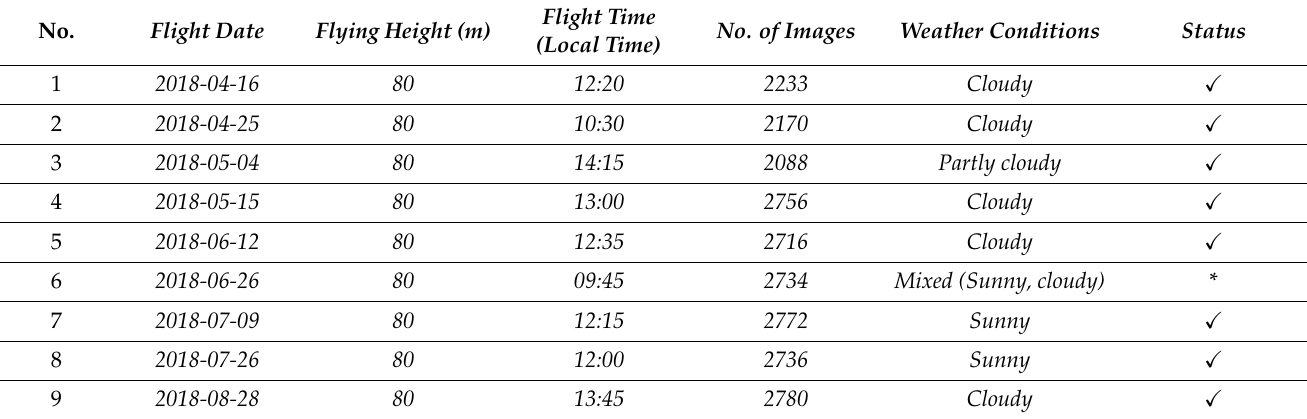
Table 2. Information on the UAV missions conducted during 2018 with corresponding number of images and weather conditions. Note ‘*’represents one flight for which images were not processed due to large variation in irradiance data during the